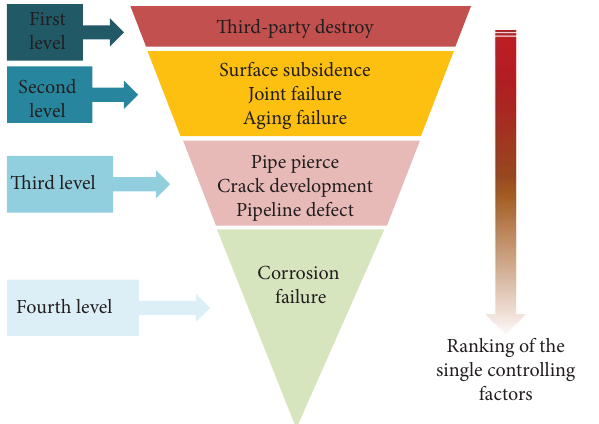
Figure 7: Rank of the main failure factors of buried PE pipelines [20].